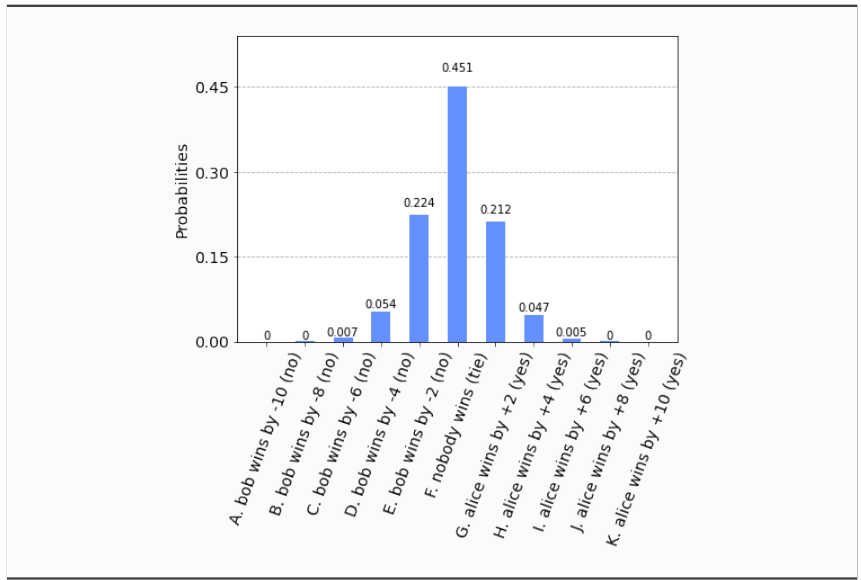
Figure 27. The possible outcomes when n A = n B = 8, r A = r B = 0.5, and n I = 0.